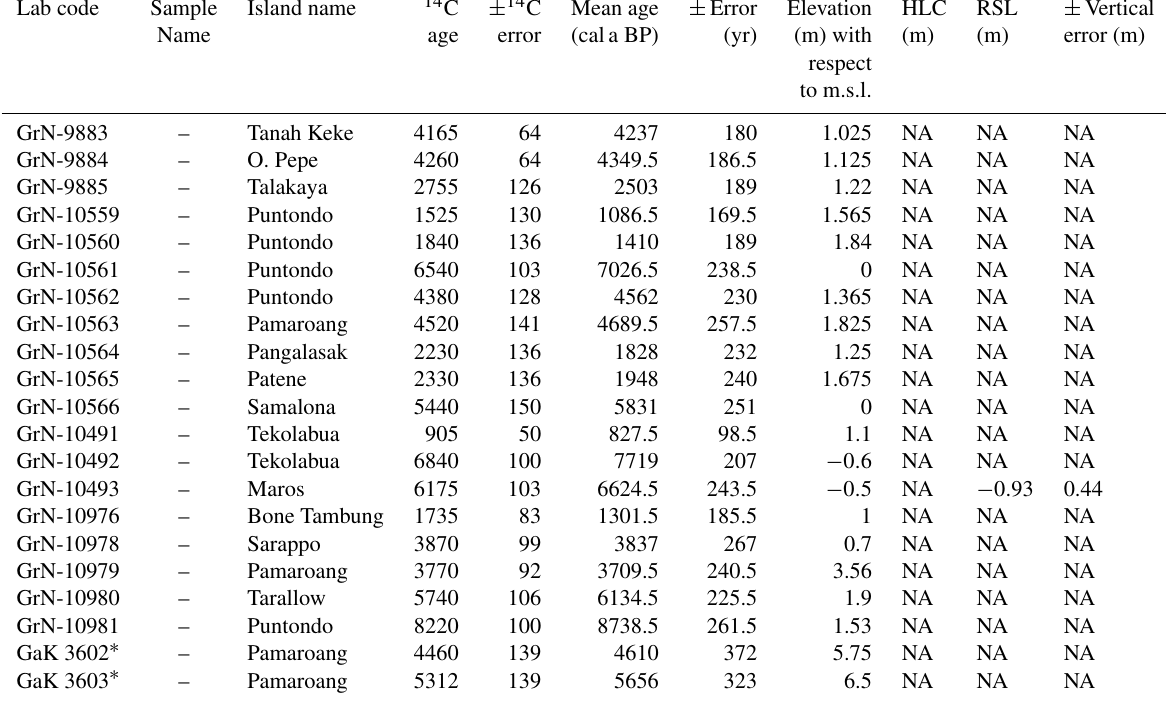
Table 4. Marine and terrestrial limiting indicators from De Klerk (1982) and Tjia et al. (1972) studied in different locations in SW Sulawesi and the Spermonde Archipelago. This table is an extract from the database by Mann et al. (2019b). The elevation–age plot of these data is shown in Fig.